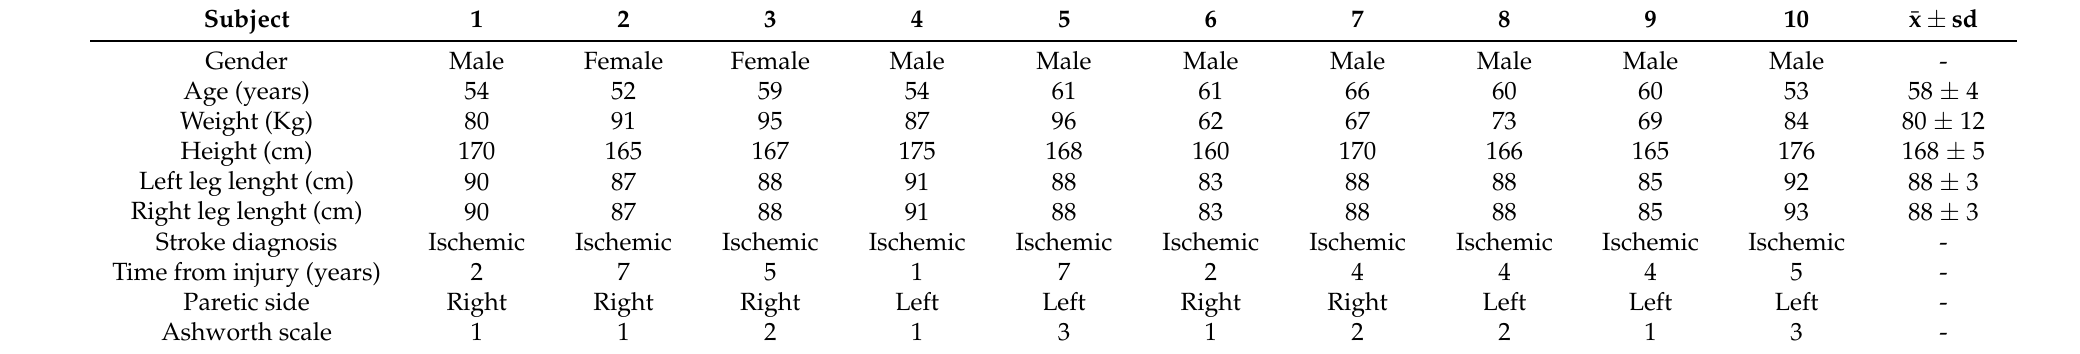
Table 1. Subjects’ anthropometric measurements and clinical